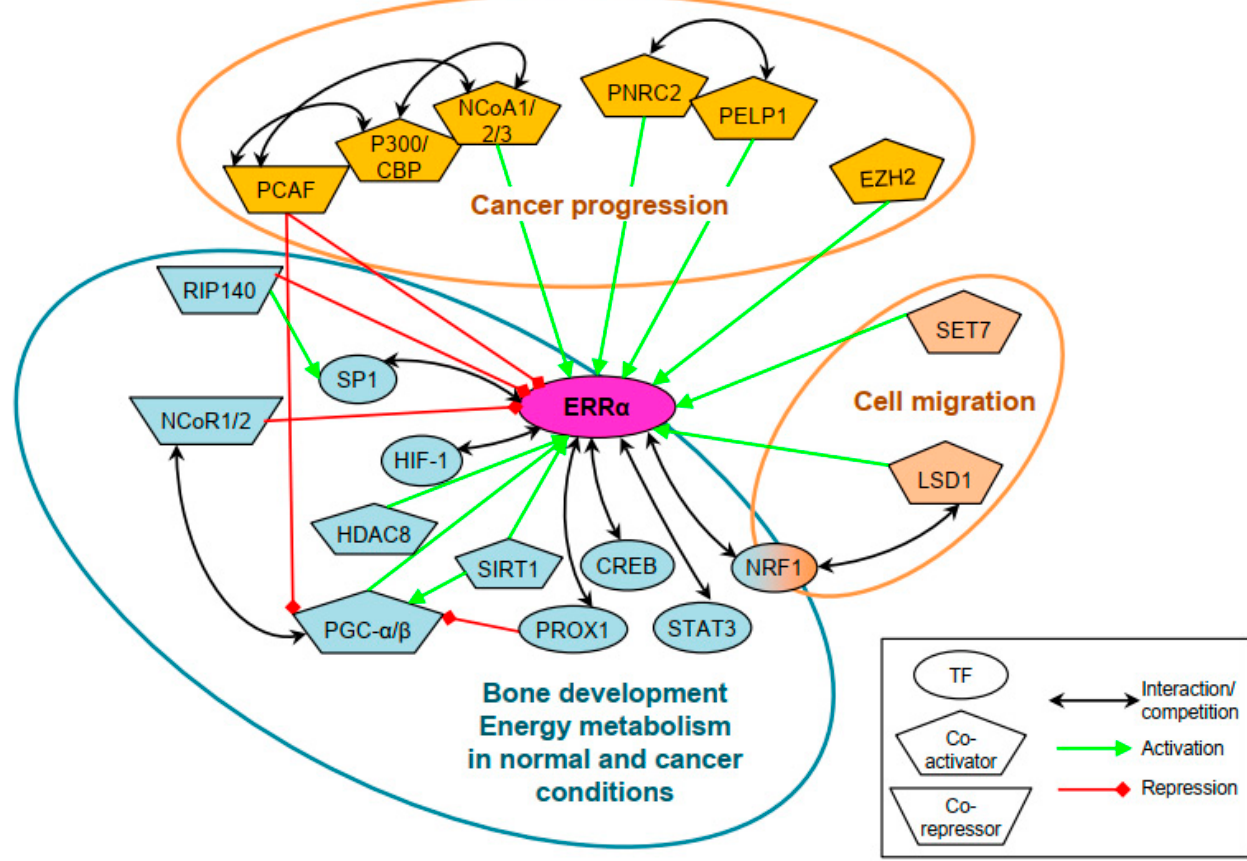
Figure 3. Transcriptional co-regulators of ERR α and related cellular functions. Coactivators and corepressors of ERR α already identified in various conditions through various mechanisms are shown. They are involved in three main cellular functions: bone development, energy metabolism, and cancer development.